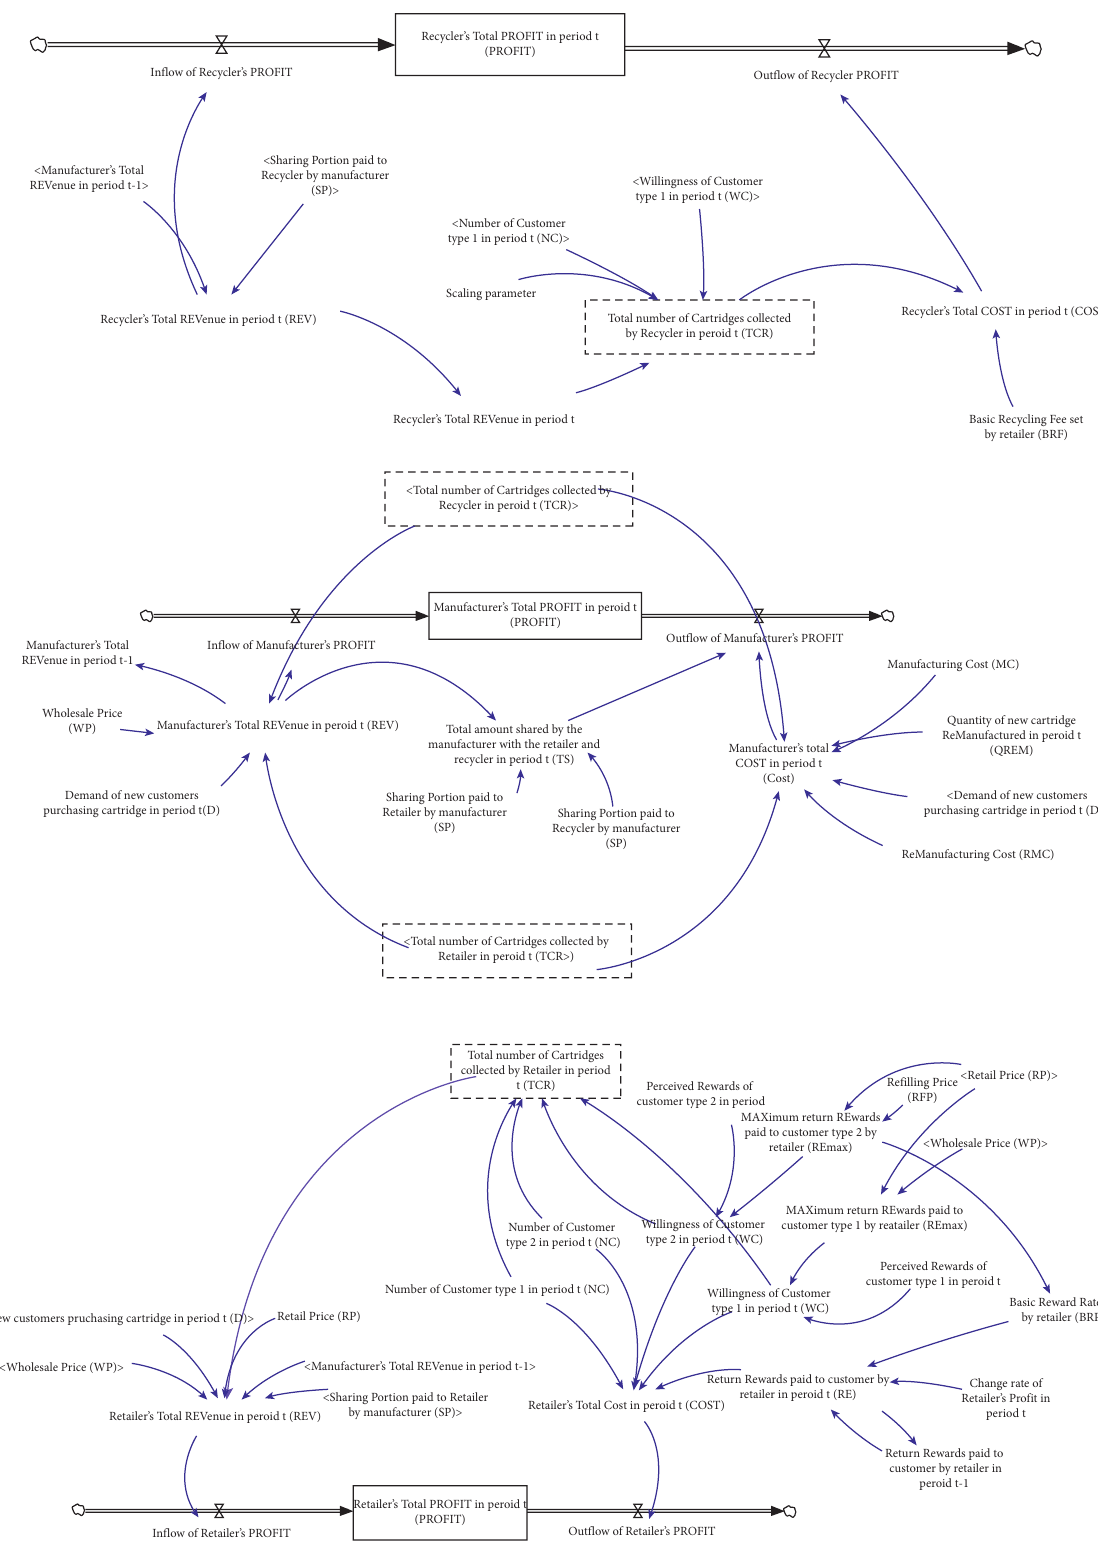
Figure 2: CLSC with a single manufacturer, single retailer, and single